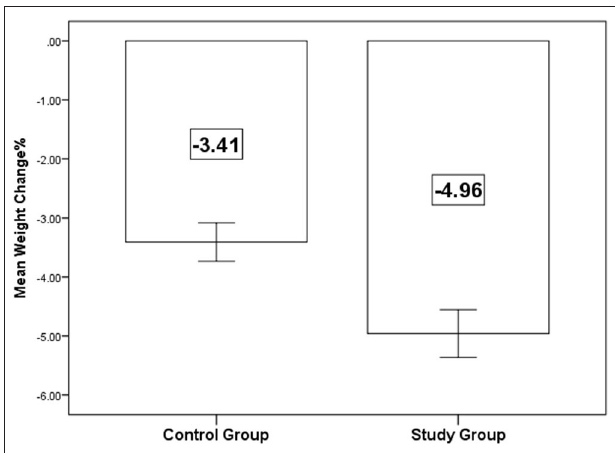
FIGURE 2 | Mean percent change in the body weight on discharge.